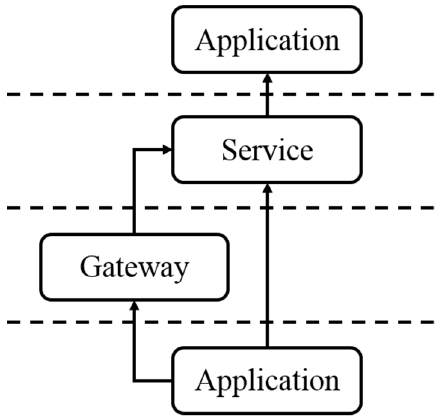
Figure 1. A high-level Sensor Web and Internet of Things (SW-IoT) architecture [4].